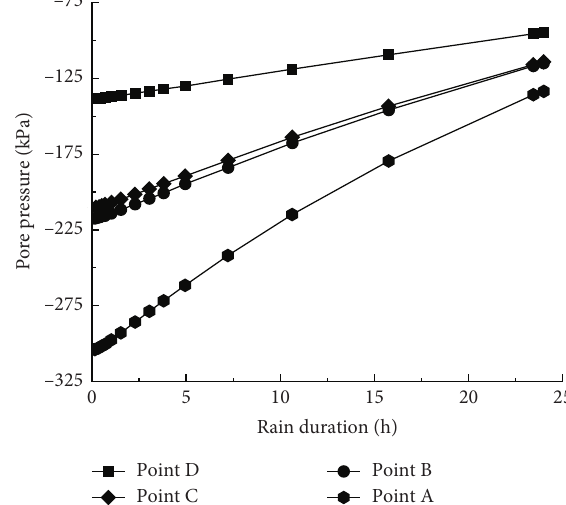
Figure 11: Curves of pore pressure-rain duration at each point after rainfall for 24h.